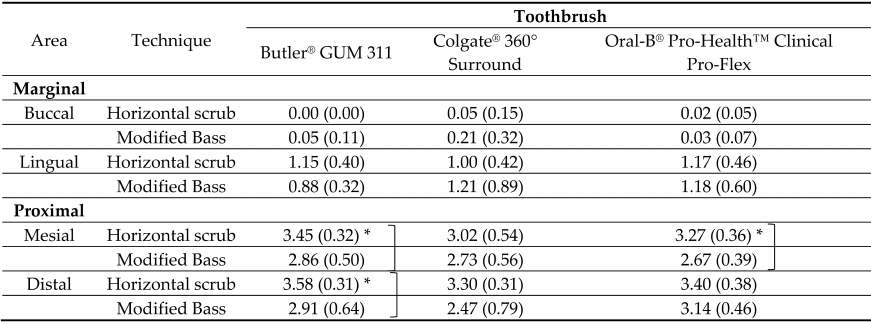
Table 2. Mean Plaque Marginal index (SD) after